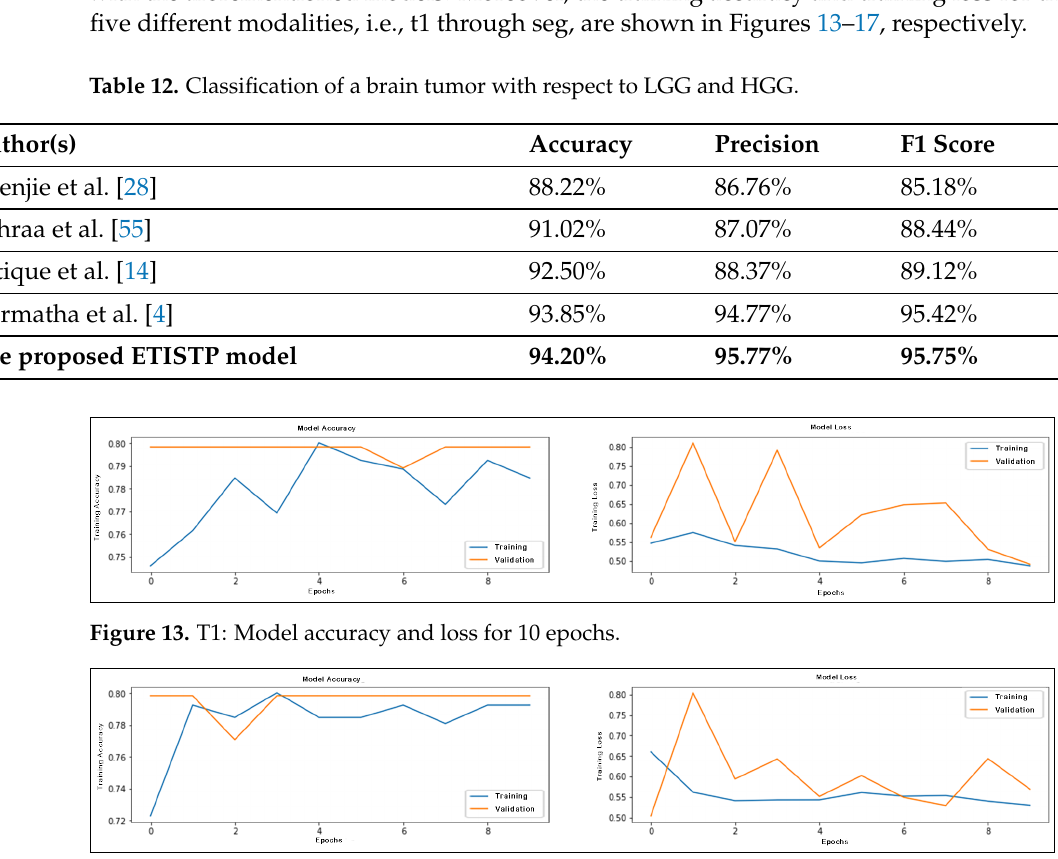
Figure 14. T1ce: Model accuracy and loss for 10